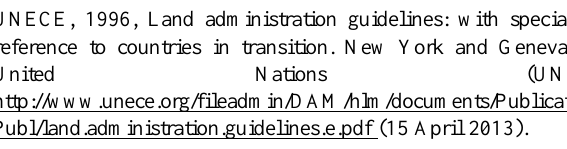
FIG, 1995, The FIG Statement on the Cadastre.